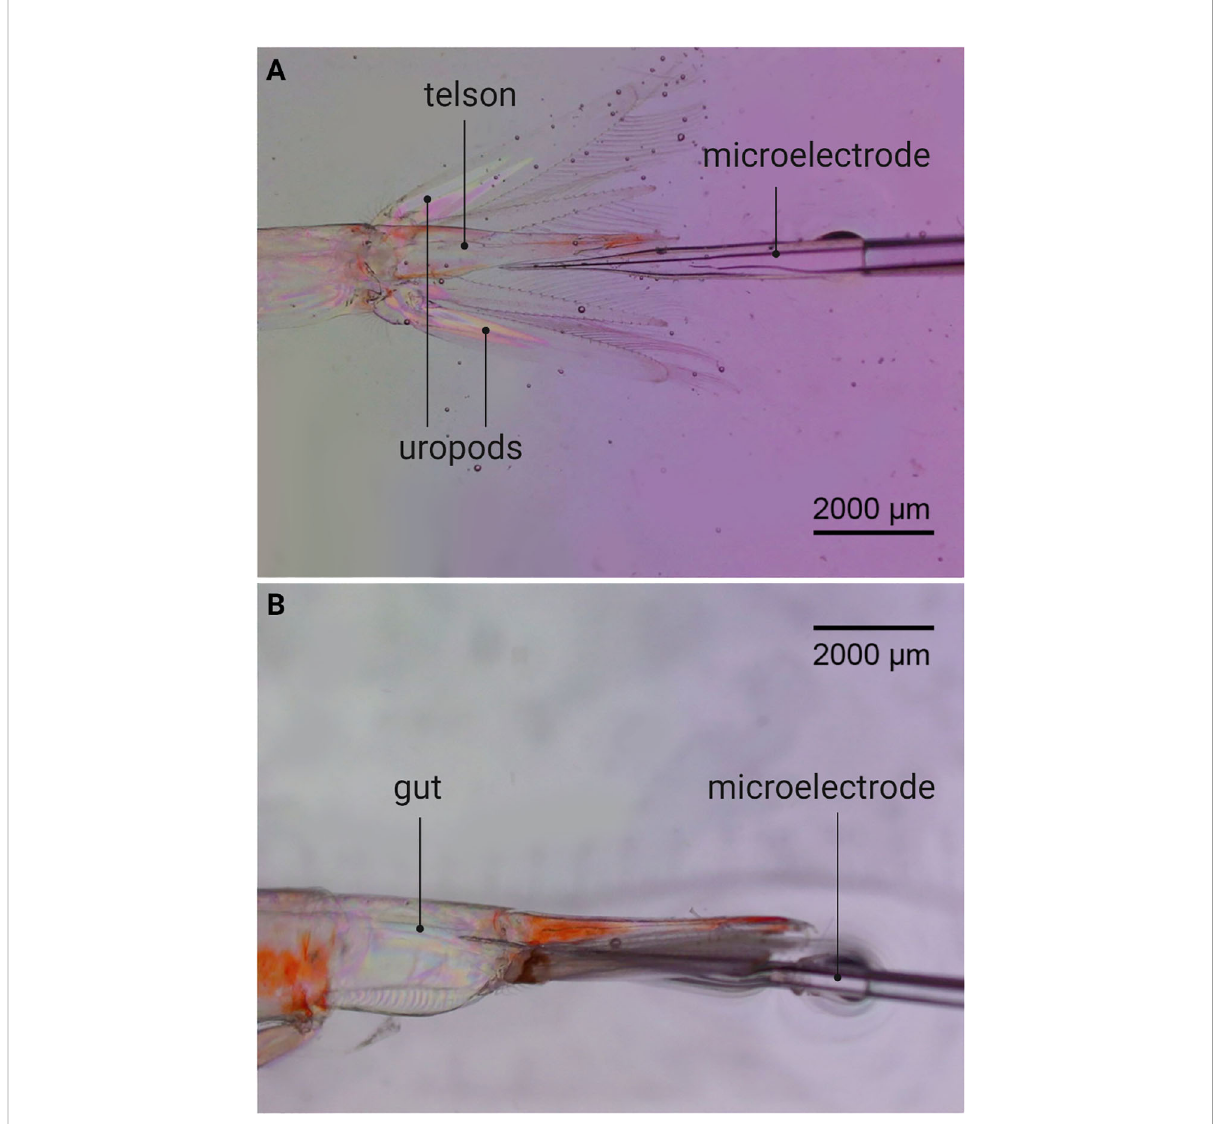
FIGURE 2 Oxygen micro-pro fi ling of krill guts. (A) Microelectrode in the area enclosed by the telson and uropods of Meganyctiphanes norvegica , before entering the krill gut. (B) Microelectrode inside the gut of M. norvegica